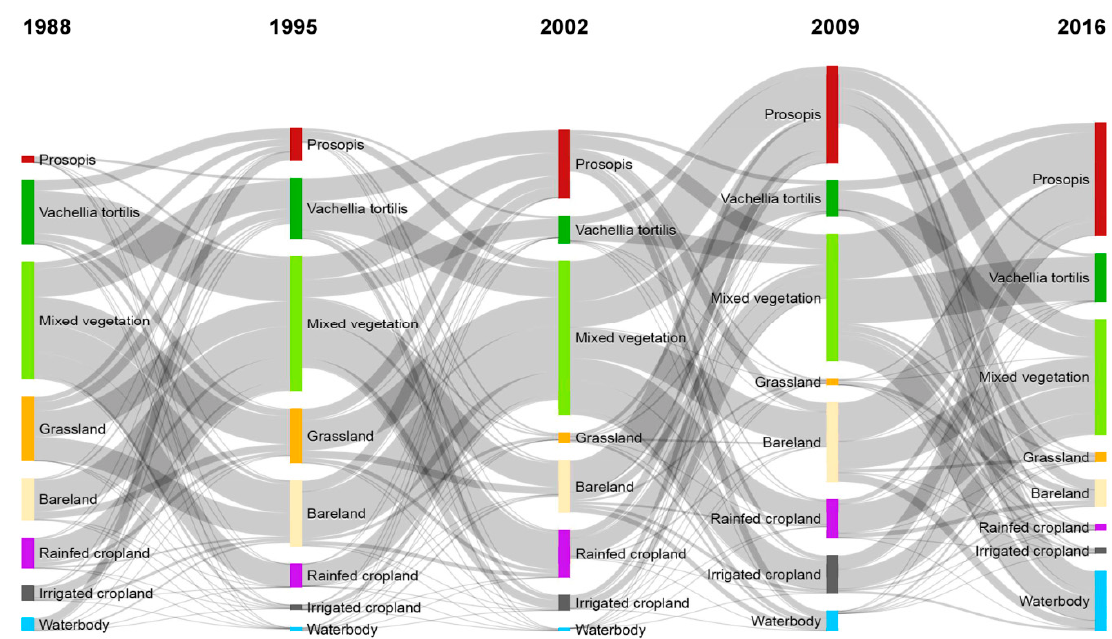
Figure 5. A Sankey plot showing the area changes from one class to the other for all time intervals. 37